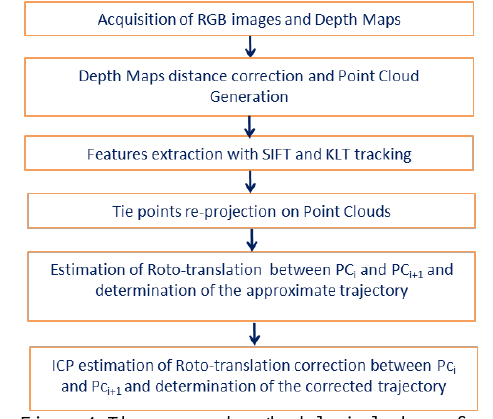
Figure 4. The proposed methodological scheme for recovering Kinect trajectory